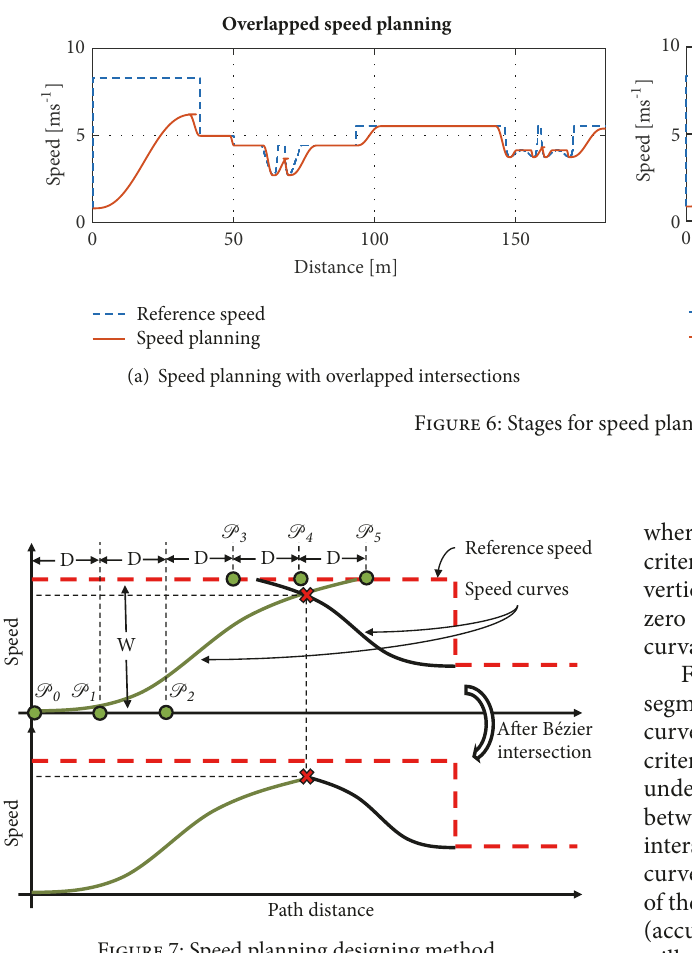
Figure 7: Speed planning designing